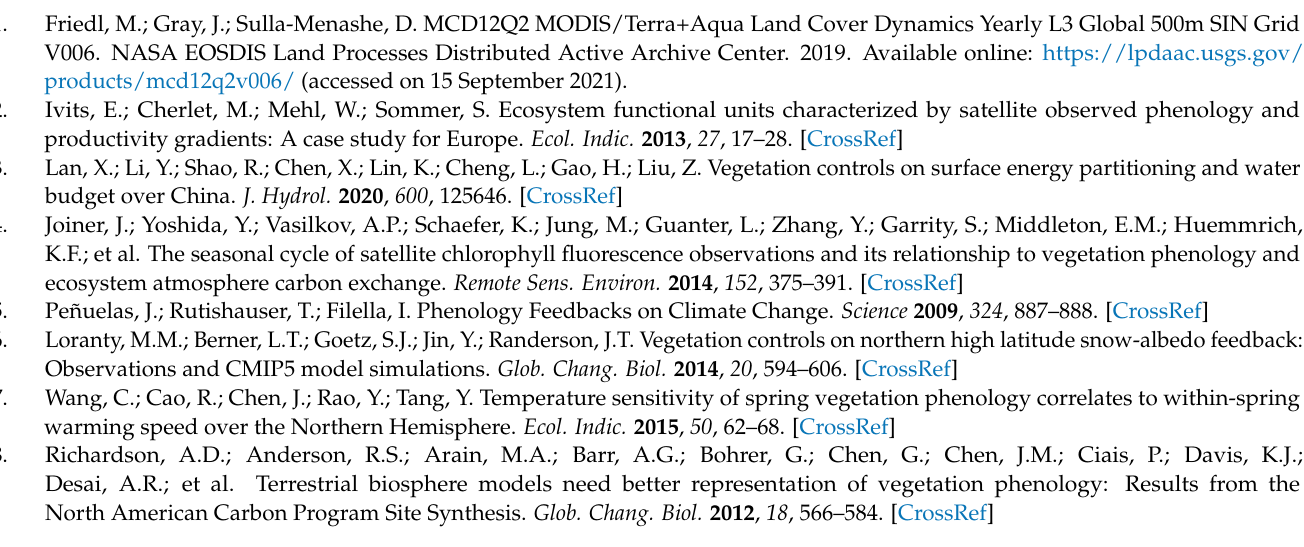
Table S1: IGBP legend and class definitions of the MCD12C1 product. Figure S1: The 14-year averaged SOS over the NH derived from (a) MCD12Q2-C6 and (b) MCD12Q2-C5 during 2001–2014, and (c) differences. The (d) latitudinal and (e) longitudinal differences between MCD12Q2-C6 and MCD12Q2-C5 during